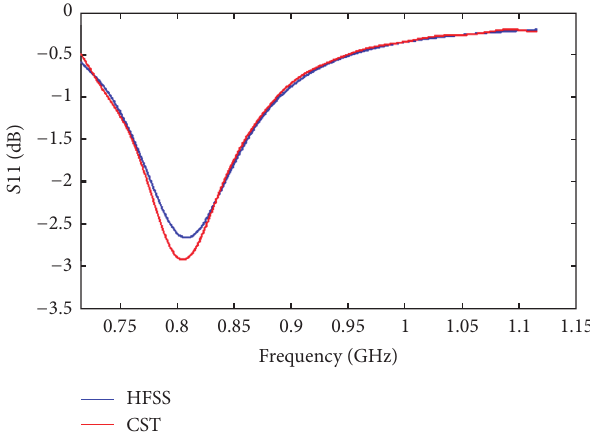
Figure 3: Return loss 𝑆11 of the 3D spherical antenna (Figure 2).